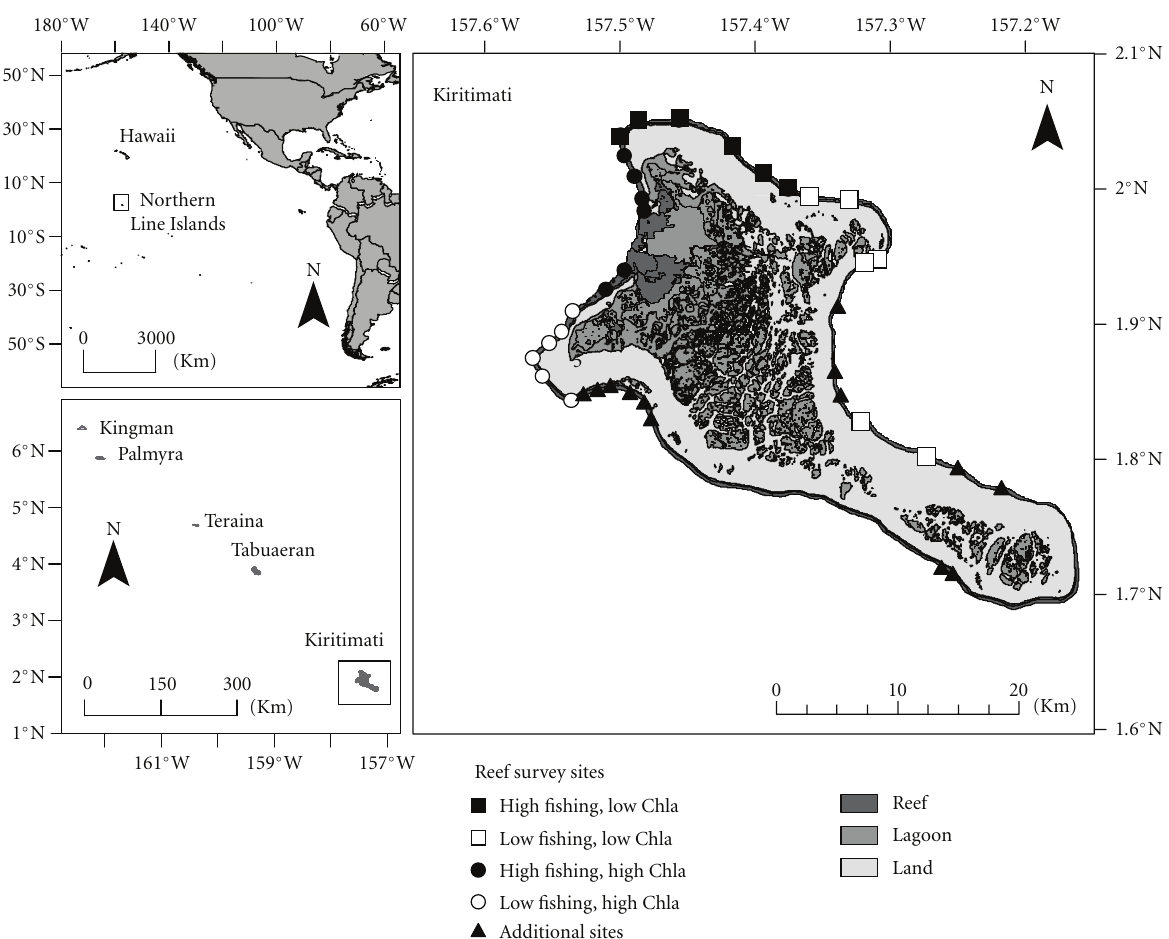
Figure 1: Location of ecological survey sites on Kiritimati, Line Islands, Republic of Kiribati. Twenty-four sites were chosen to create a balanced natural factorial experimental design to test the e ff ect of nutrients (proxied by chlorophyll- a ) and fishing on the fish and benthic communities. An additional 13 sites were chosen to capture the full fishing gradient and test